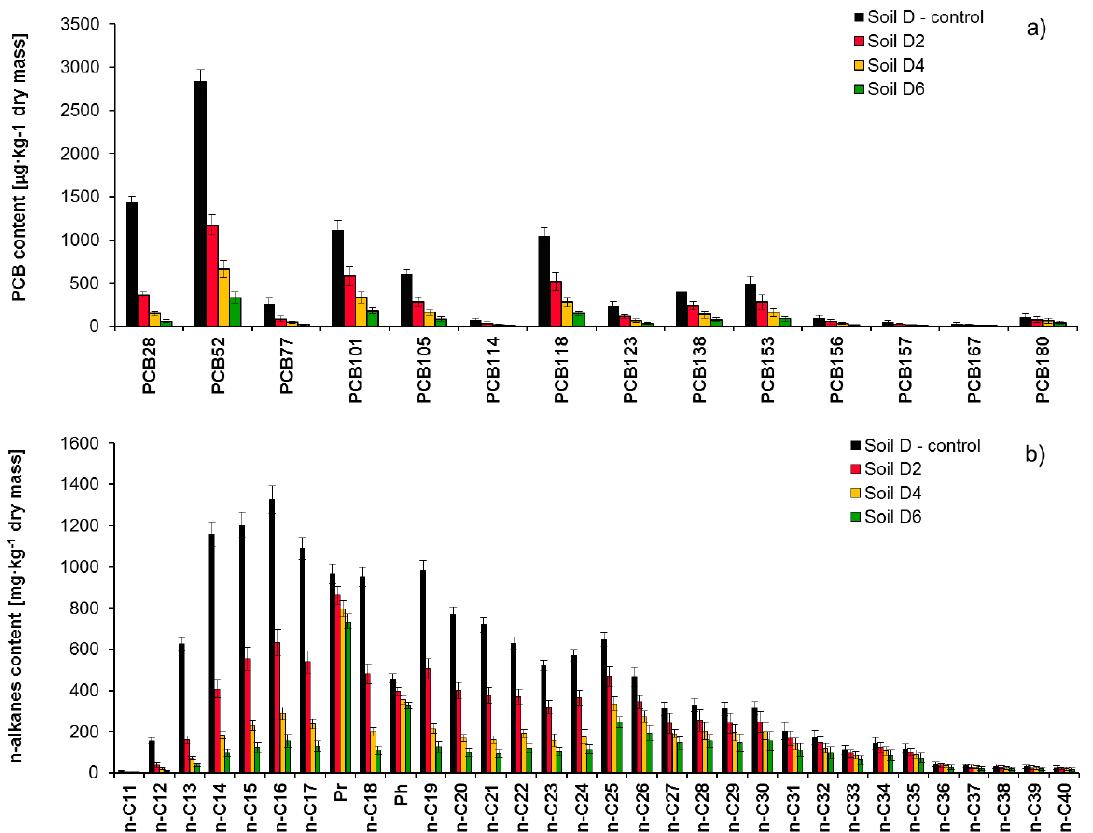
Figure 6. Residual content of ( a ) PCB congeners and ( b ) n-alkanes in non-sterile soil contaminated with both PCBs and petroleum hydrocarbons (Soil D) after 2 (Soil D2), 4 (Soils D4) and 6 (Soil D6) months of inoculation with mixed culture M1 (ex-situ prism method), (repetition number n = 7–10, p < 0.05). Control non-inoculated Soil D.